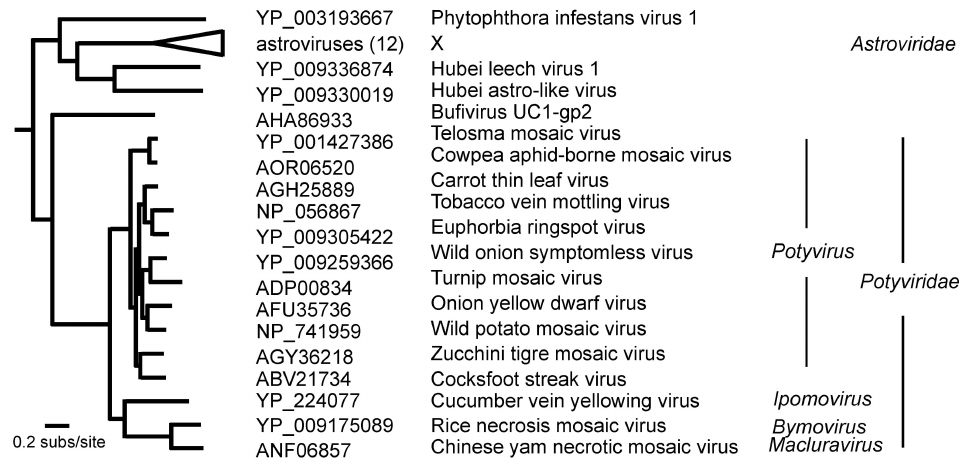
Figure 1. The phylogeny of the RdRps of selected potyvirids, and of the other most closely related viral RdRps (redrawn from [24]).